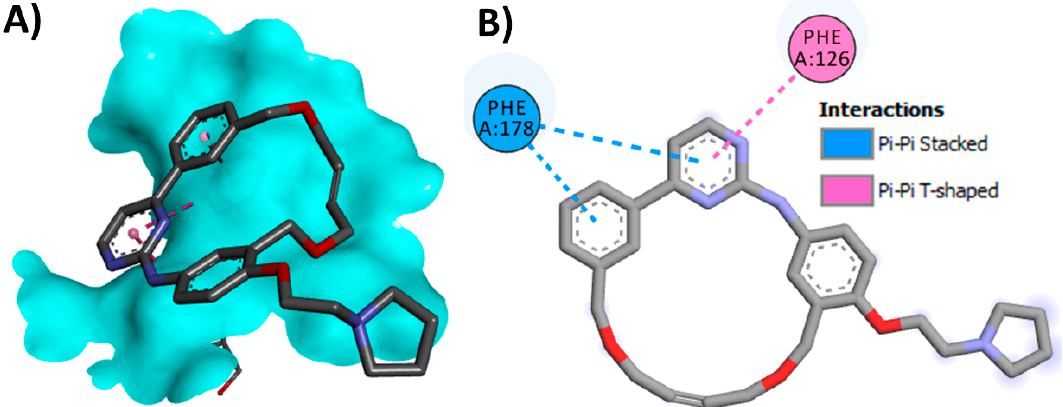
Figure 41. Binding modes of pacritinib (shown as sticks) into human quinone reductase 2 (NQO2) (pdb: 5LBZ): ( A ) 3D binding mode, receptor shown as a hydrogen bond surface; ( B ) 2D binding mode showing different types of binding interactions; this figure was generated using Discovery Studio Visualizer